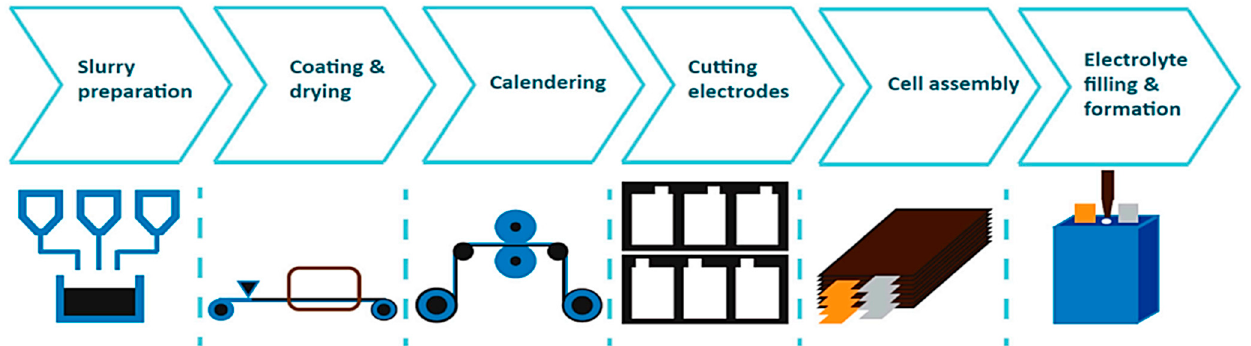
Figure 4. Ba tt ery production for process parameter optimization [94]. Figure 4. Battery production for process parameter optimization